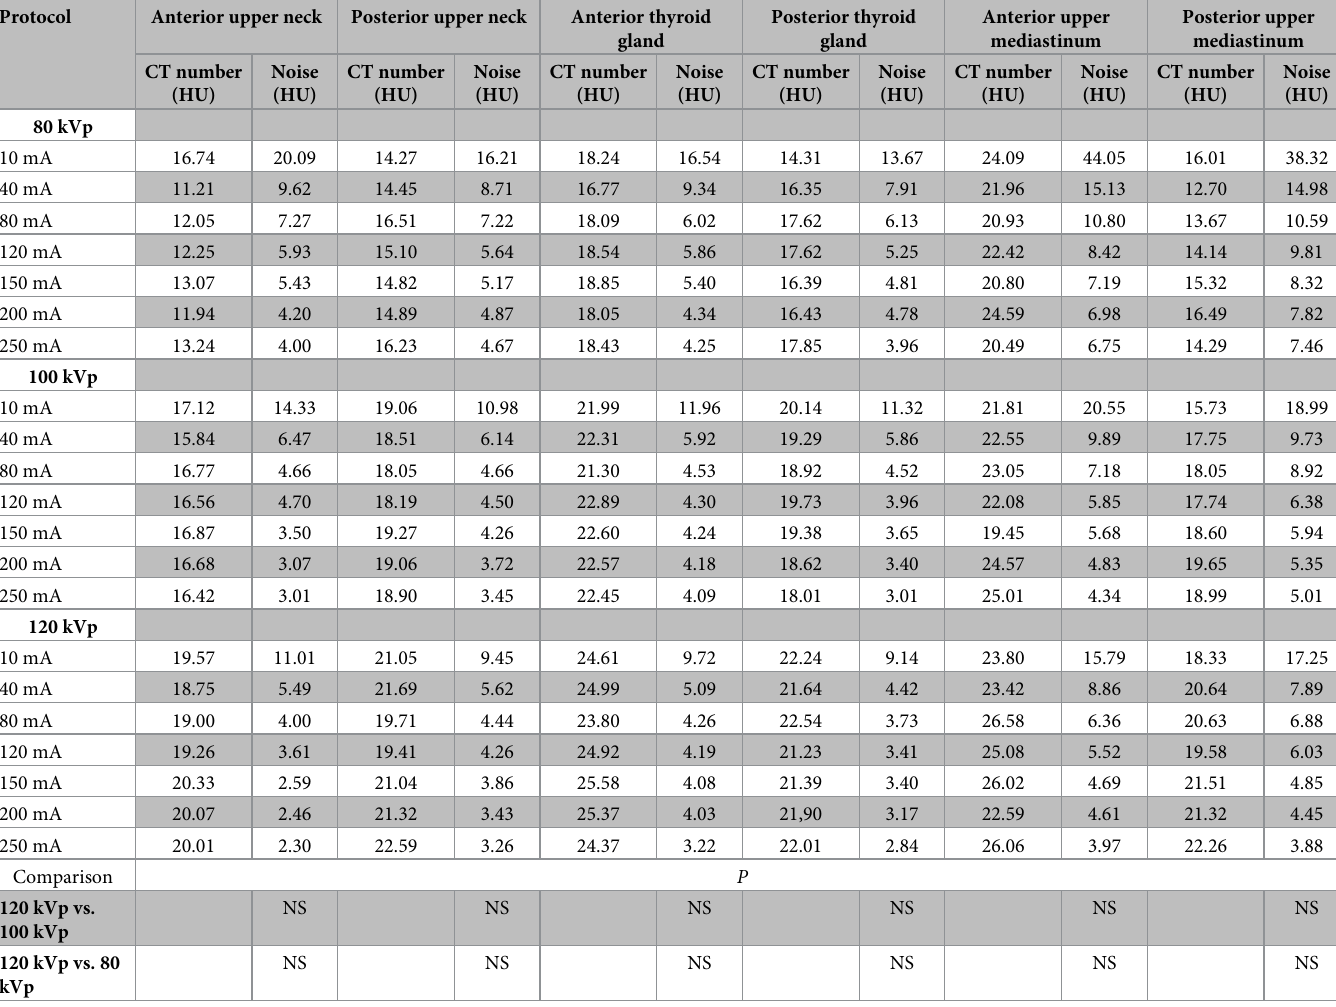
Table 3. Results of objective analyses of reconstruction techniques for computed tomography imaging of simulated neck scans of a child aged 5 years. Protocol Anterior upper neck Posterior upper neck